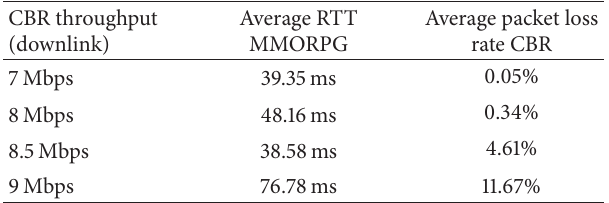
Table 6: Summary of the tests: average RTT of all the MMORPG flows; packet loss rate in the